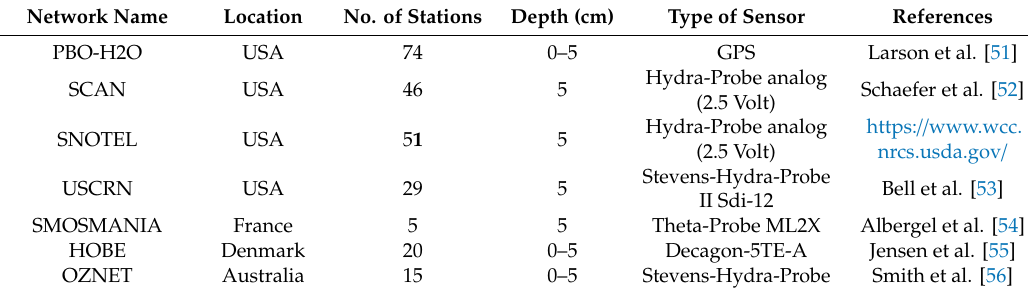
Table 1. The main characteristics of ISMN validation sites were used in this study.